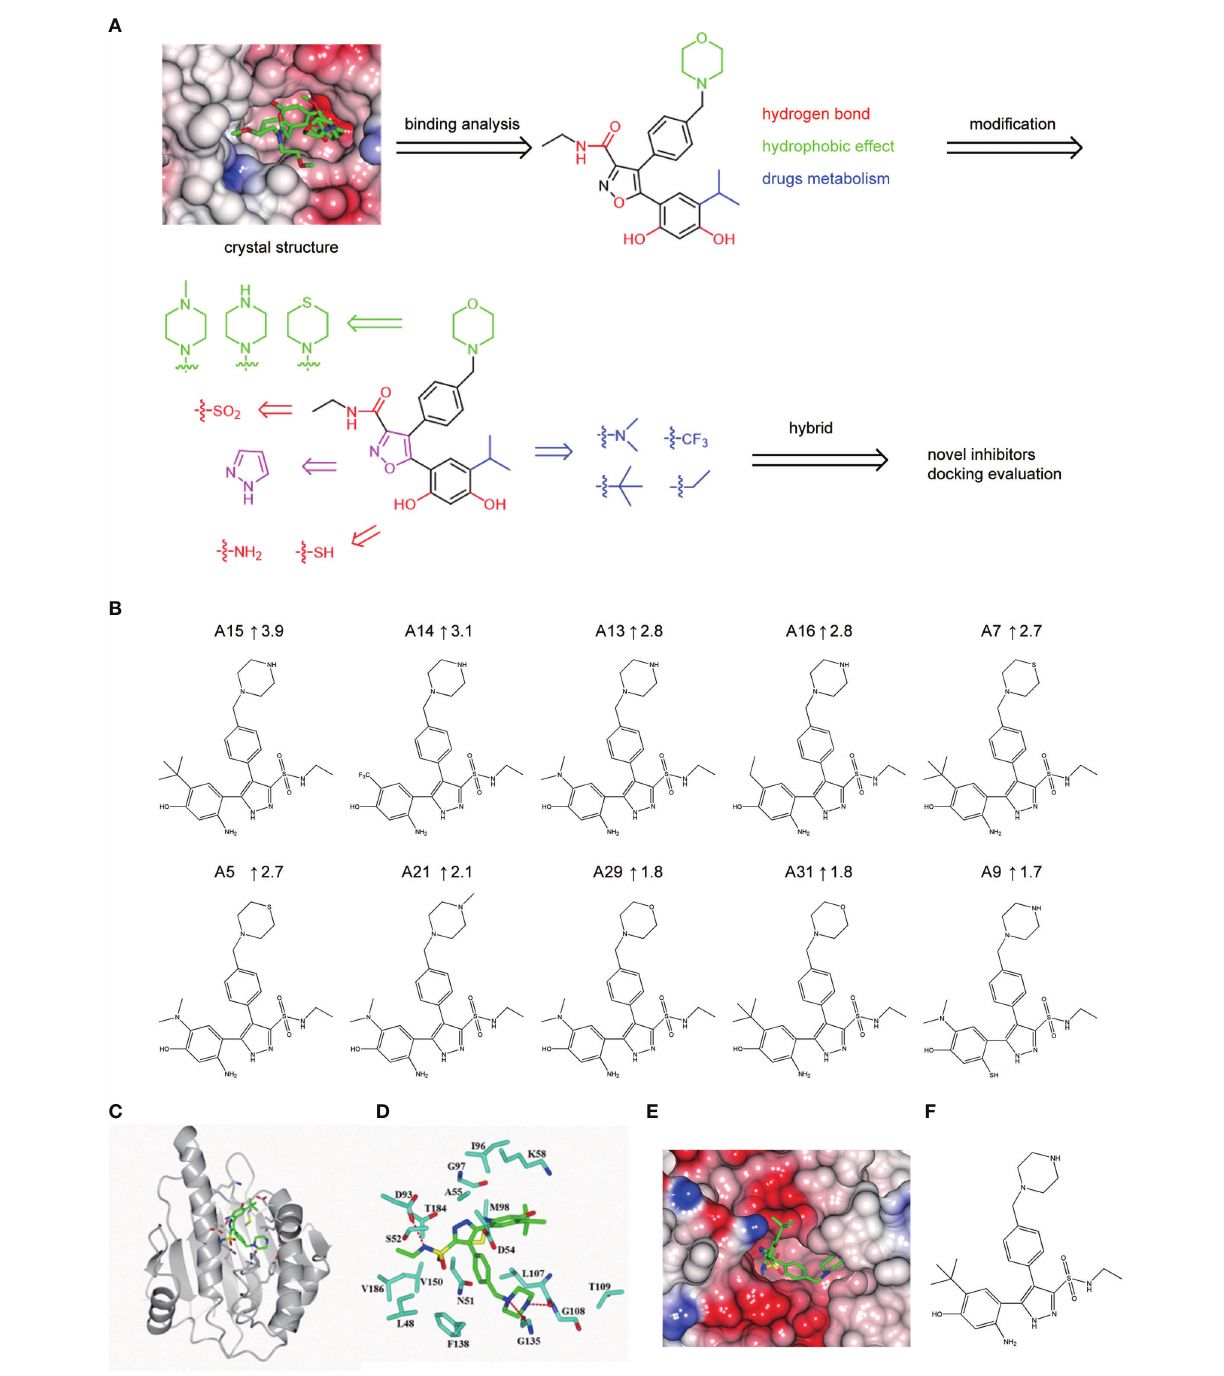
FIGURE 4 | Hsp90 N -NVP-AUY922 complex crystal structure. (A) Overall structural view of Hsp90 N -NVP-AUY922. Hsp90 N and NVP-AUY922 were indicated by cartoon and stick, respectively. (B) Intermolecular forces between Hsp90 N and NVP-AUY922. For NVP-AUY922, the carbon, nitrogen and oxygen atoms were colored in green, blue and red, respectively. For Hsp90 N , the carbon, nitrogen, oxygen and sulfur atoms were shown in cyan, blue, red and yellow, respectively. The red dashed line represents the hydrogen bond. The red spheres showed water molecules. (C) Distribution of electrostatic potential on Hsp90 N -NVP-AUY922 crystal structure surface. Red colored surface re fl ects the negative charge of electrostatic potential, and blue for positive charge. (D) Electron density map (2 Fo - Fc ) of NVP- AUY922. The map was calculated in the vicinity of NVP-AUY922. (E) Molecular structure of